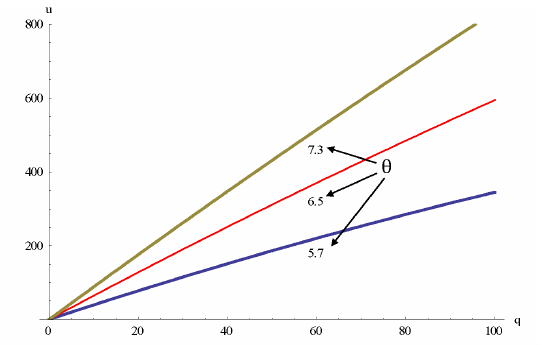
Figure 2. Utility function with θ